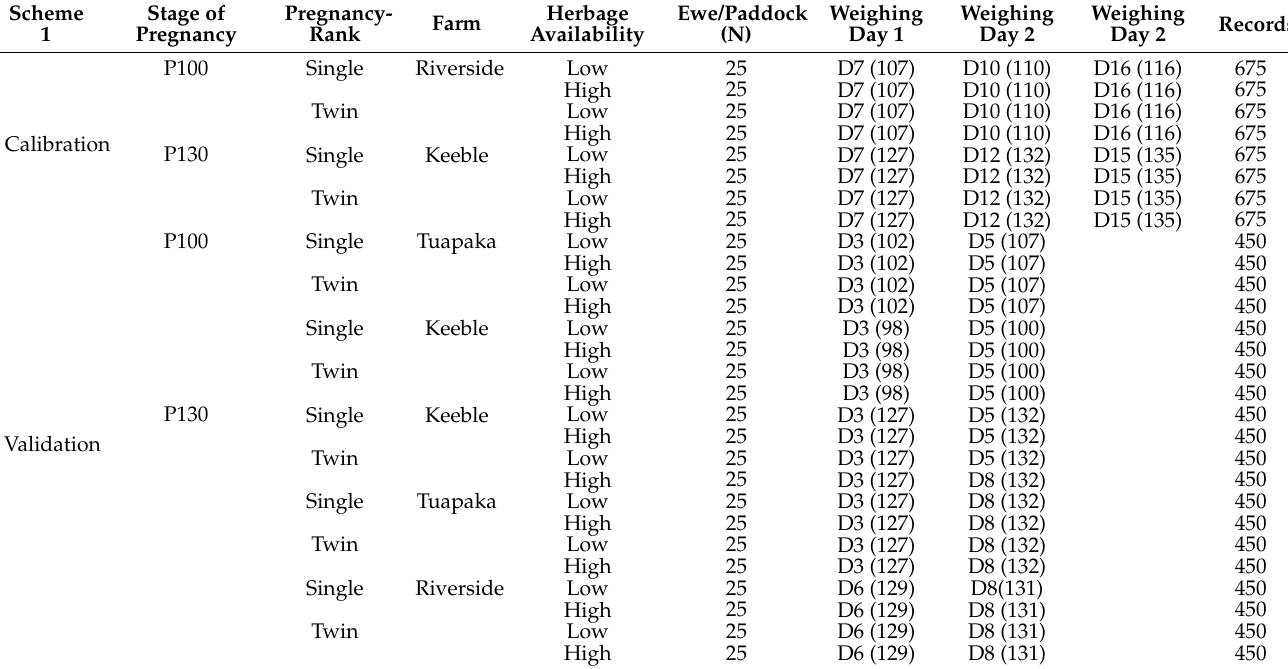
Table 1. Sample size, weighing day (D) (pregnancy day in parenthesis) and liveweight records of ewes by study stage, stage of pregnancy, pregnancy-rank, farm and herbage availability. Scheme